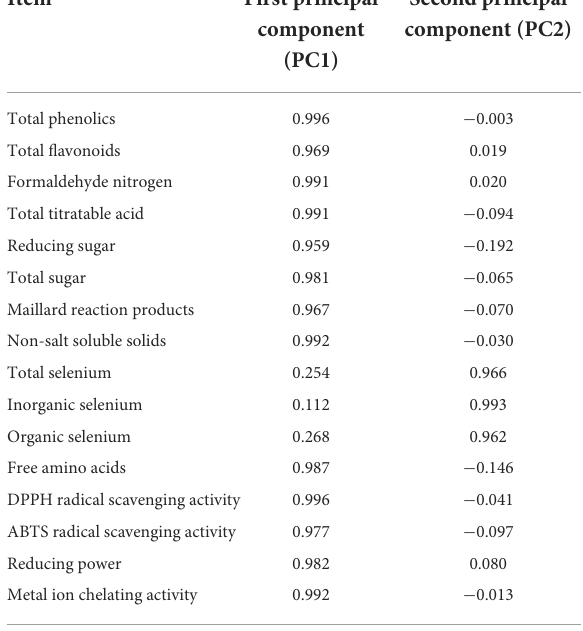
TABLE 7 Source of variation for the principal component (PC).